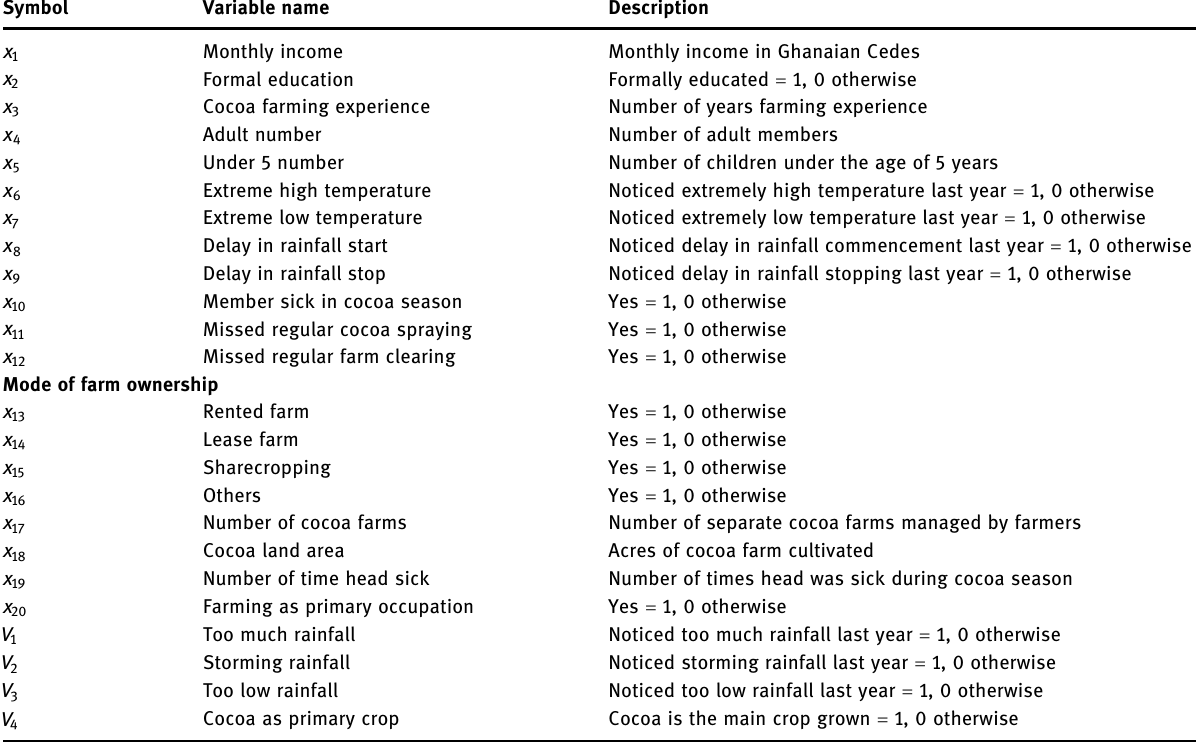
Table 1: Description of explanatory